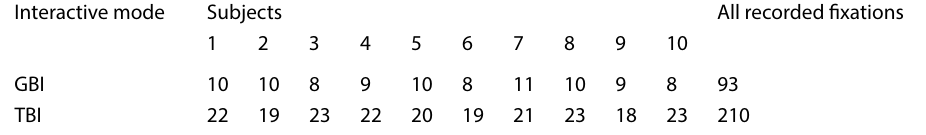
Table 8 The fixation number of AOI